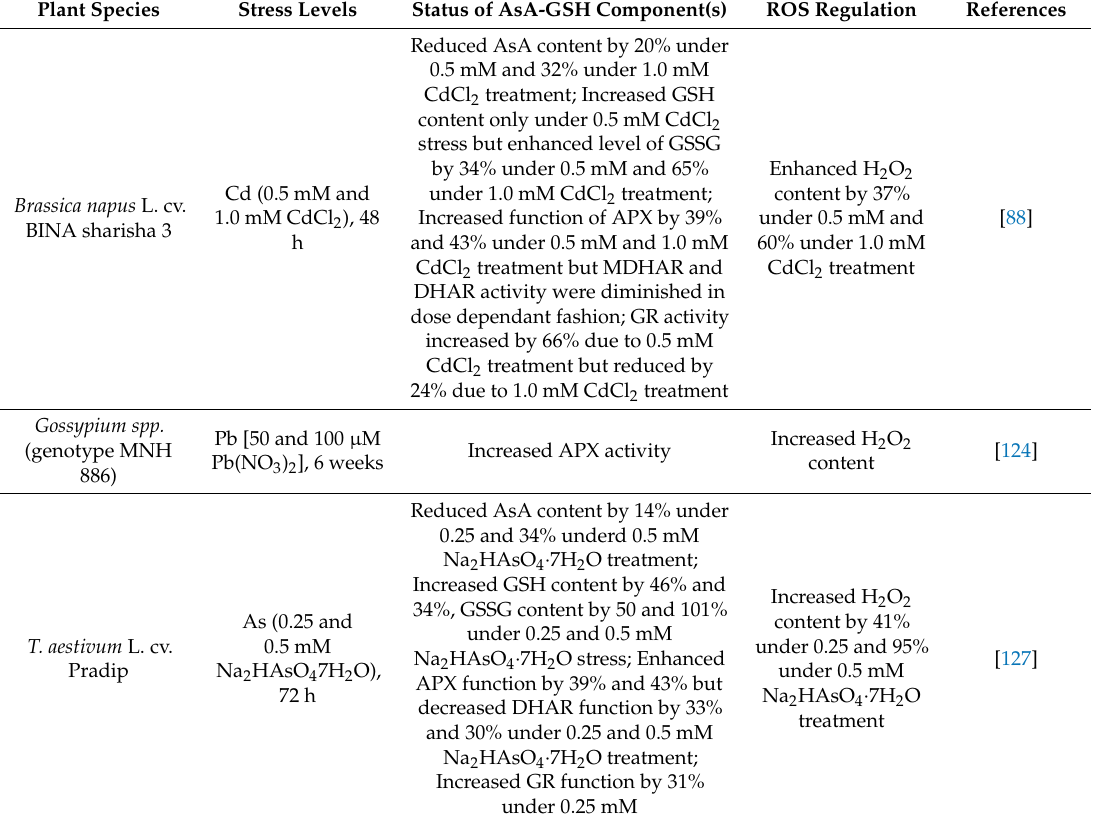
Table 2. Status of AsA-GSH in regulating oxidative stress under metal / metalloid stress. Plant